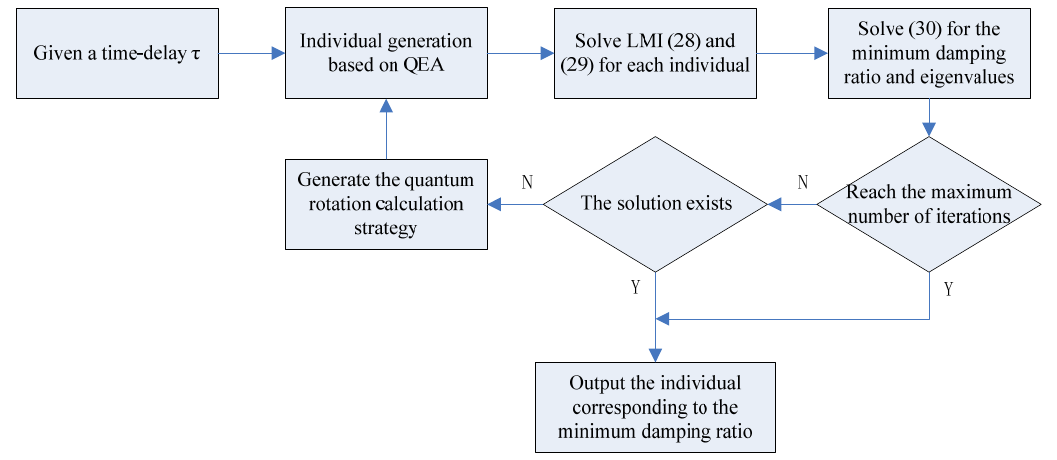
Figure 7. Flow chart of the controller design algorithm.